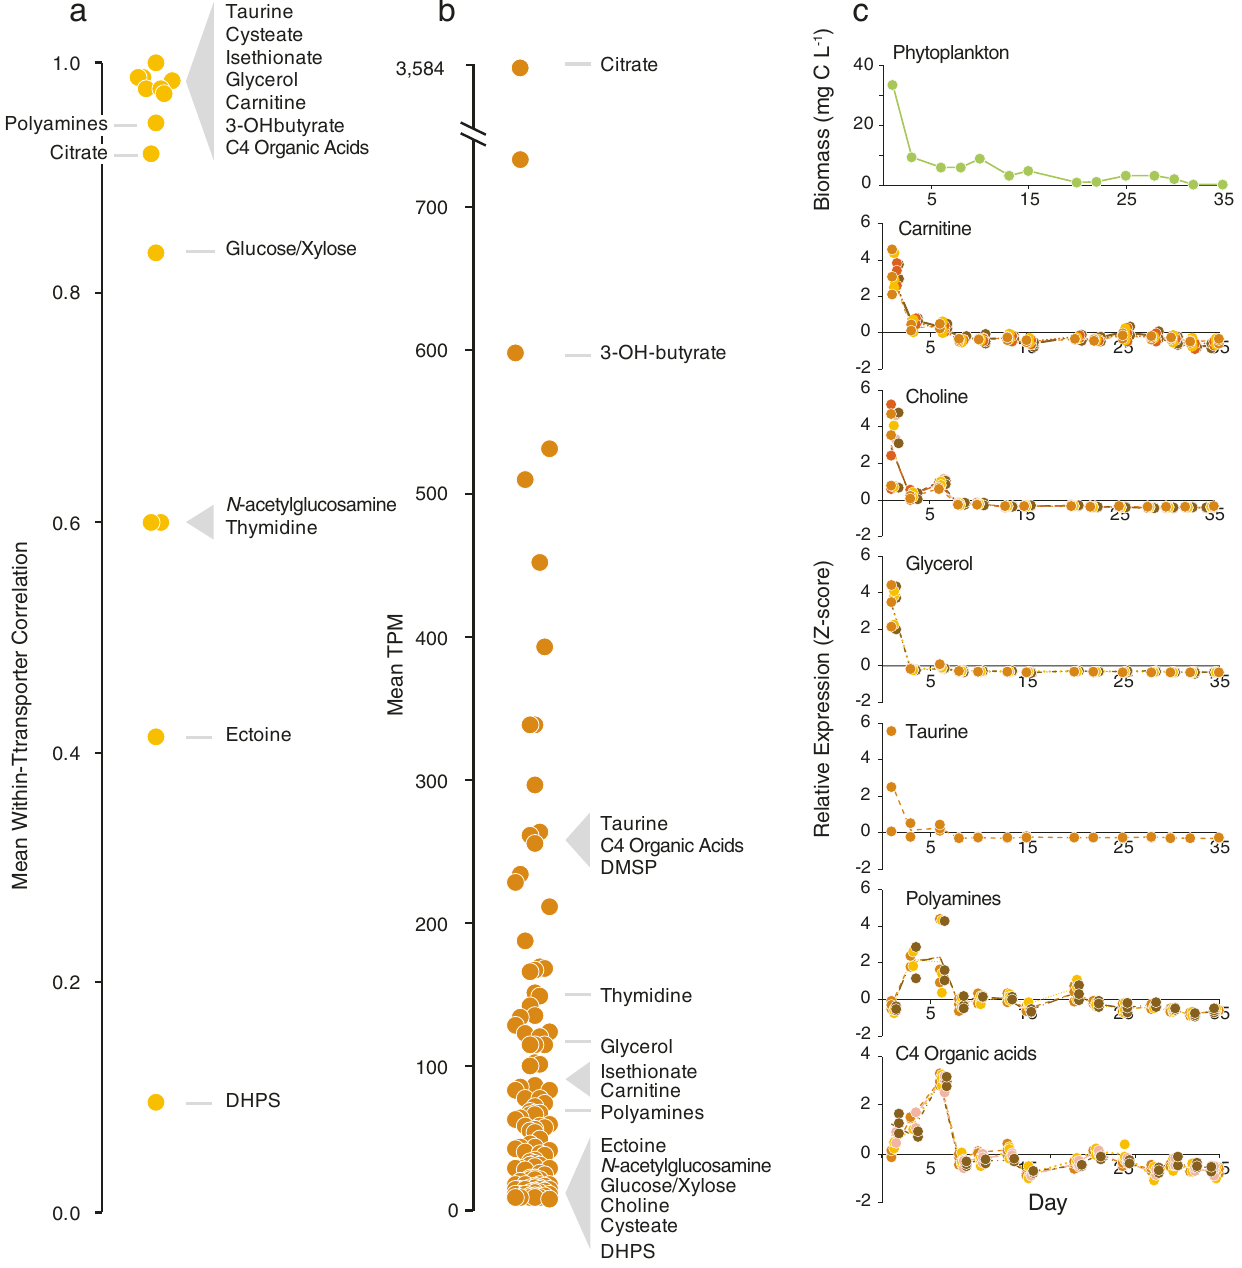
Fig. 4 Transporter expression in a Monterey Bay invasion study. a Mean correlation coef fi cients of relative expression levels of genes within multi-component transporter systems in Monterey Bay, in Fall, 2016. b Mean relative expression levels for the 126 R. pomeroyi transporter systems when introduced into Monterey Bay seawater, averaged across 14 dates. c Relative expression of selected R. pomeroy i DSS-3 transporters in Monterey Bay seawater on each of 14 dates over 35 days, normalized as Z-scores. Expression of all veri fi ed transporters is shown in Fig. S3. Transporters have 1 – 5 component genes (each colored in different shades of brown) and each component gene has three replicates plotted individually. Lines connect the component mean expression through time. Total phytoplankton biomass ( μ g C L – 1 ) during the 5-week sampling period is also narrow niche dimensions restricted to subgroups ( R. pomeroyi and its closest relatives), and on the other, broad ecological characteristics common across the group and re fl ecting core ecological roles. As is the case for many marine bacterial taxa [81], the streamlined Roseobacter species that are more numerous in ocean microbial communities are poorly repre- sented in culture collections [82]. As such, experimental gene